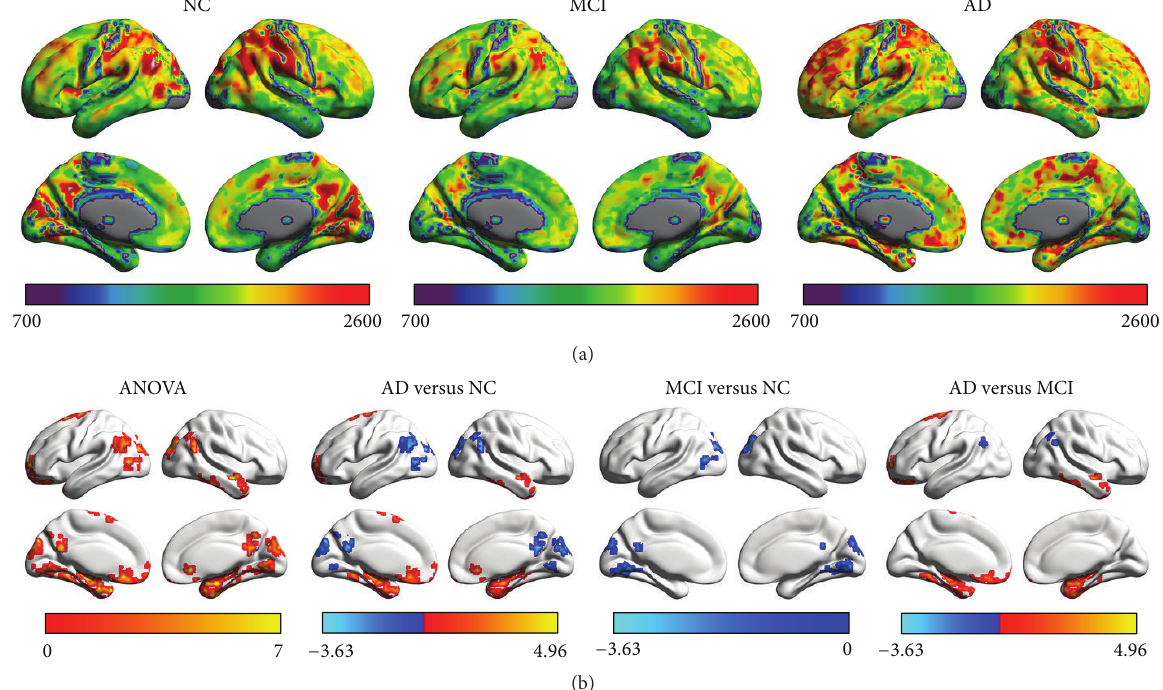
Figure 1: The FCS in AD, MCI, and control groups. (a) The images show the mean FCS in AD, MCI, and control groups. The color bar at the bottom of each picture represents the FCS value for each group. (b) The images demonstrated the significant differences among the three groups and within each pair of the groups at baseline. The color bar at the bottom of each picture represents either 𝐹 values for ANOVA or 𝑇 values for post hoc 𝑡 -tests.